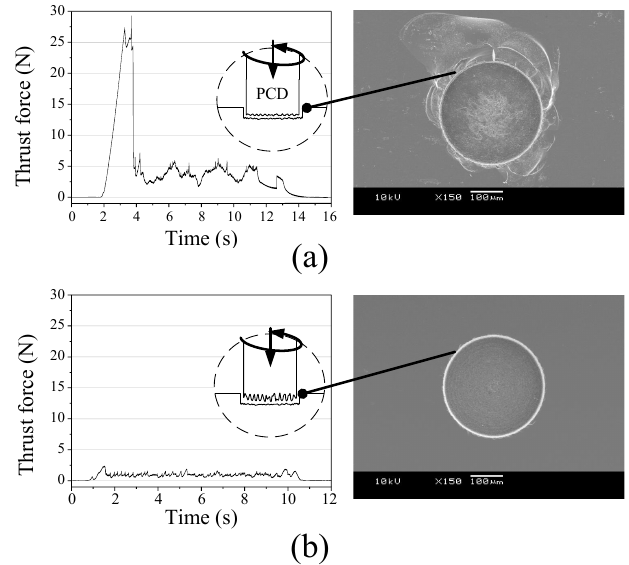
Figure 8. Comparison of thrust forces and drilled holes for different surface roughness of tools; ( a ) Rt